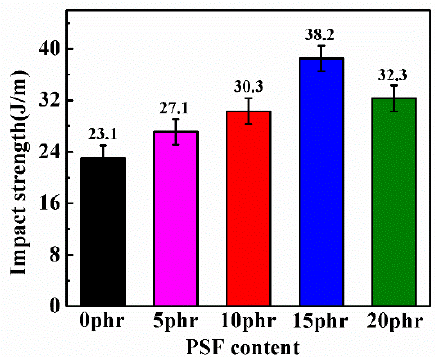
Figure 9. The Impact strength of the PSF/epoxy blends as a function of PSF content.